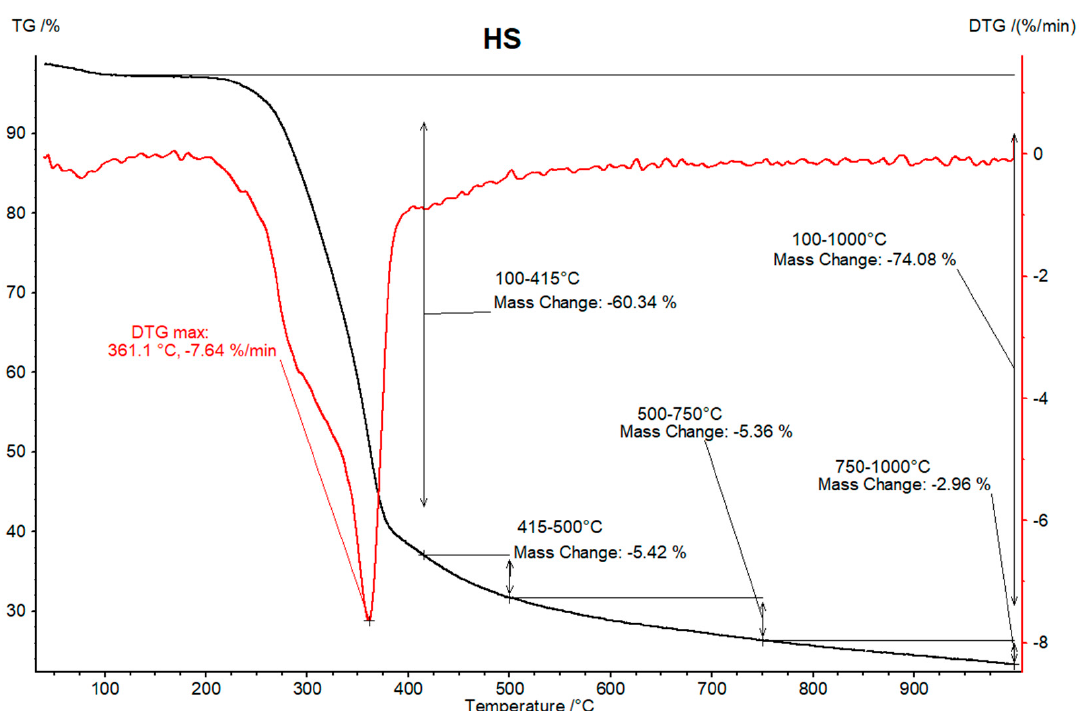
Figure A5. TG/DTG curves obtained for hazelnut shells.